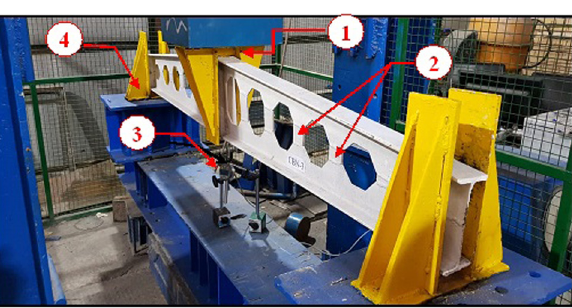
Figure 6: Test setup. 1. Applying load. 2. Expansion plates. 3. LVDT in mid - span for measure of de fl ection. 4. Restrained points for lat - eral torsional buckling.